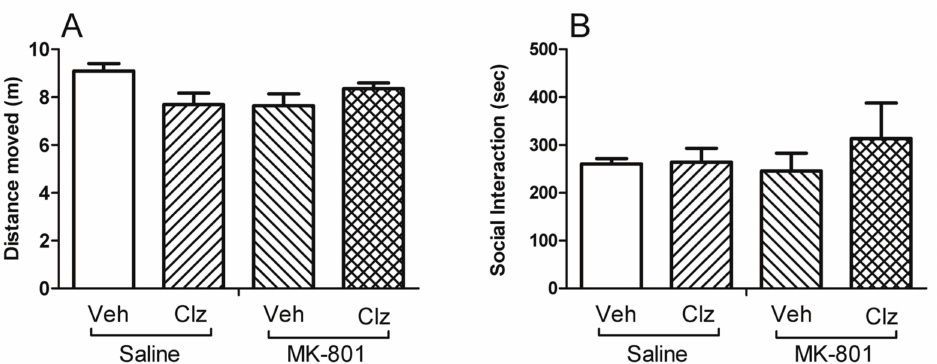
Figure 3. Neither MK-801 nor clozapine treatment altered motor reactivity to a novel environment or social interaction. Effects of clozapine 5 mg/kg (Clz), MK-801 0.1 mg/kg, and their combinations on motor reactivity to a novel environment ( A ), and social interaction duration ( B ) of the rats (Veh, vehicle), on the third and forth days of the treatments, respectively ( n =